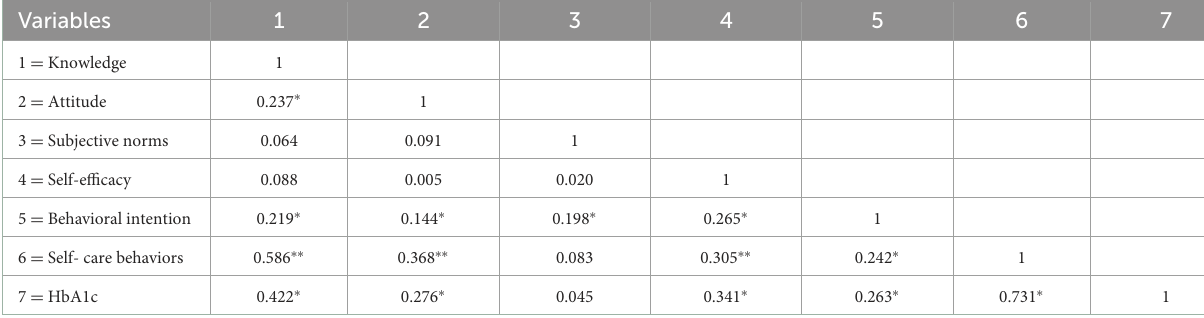
TABLE 2 Bivariate correlations of ETRA variables and self-care behaviors among diabetic patients. Variables